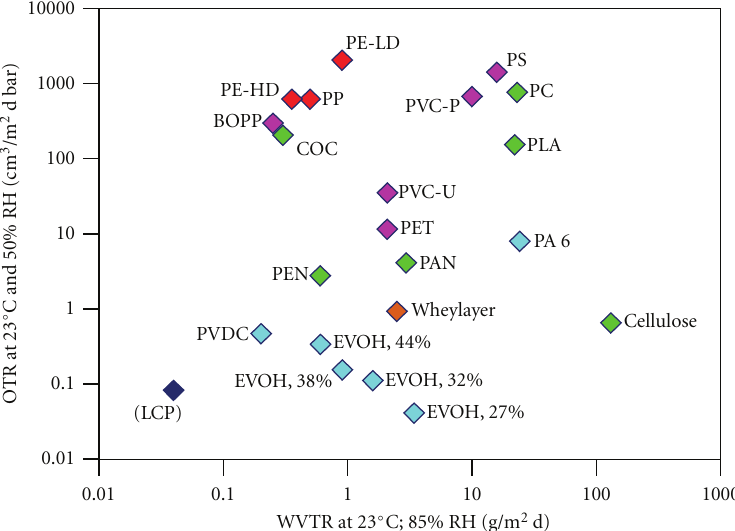
Figure 5: Barrier properties of whey-based layer versus other plastics commonly used in the packaging industry. described scale method, barrier properties in the range of OTR Q 100 = 1-2 [cm 3 (STP)/m 2 d bar] and of WVTR Q = 2-3 [g/m 2 d] could be achieved (see Figure 100